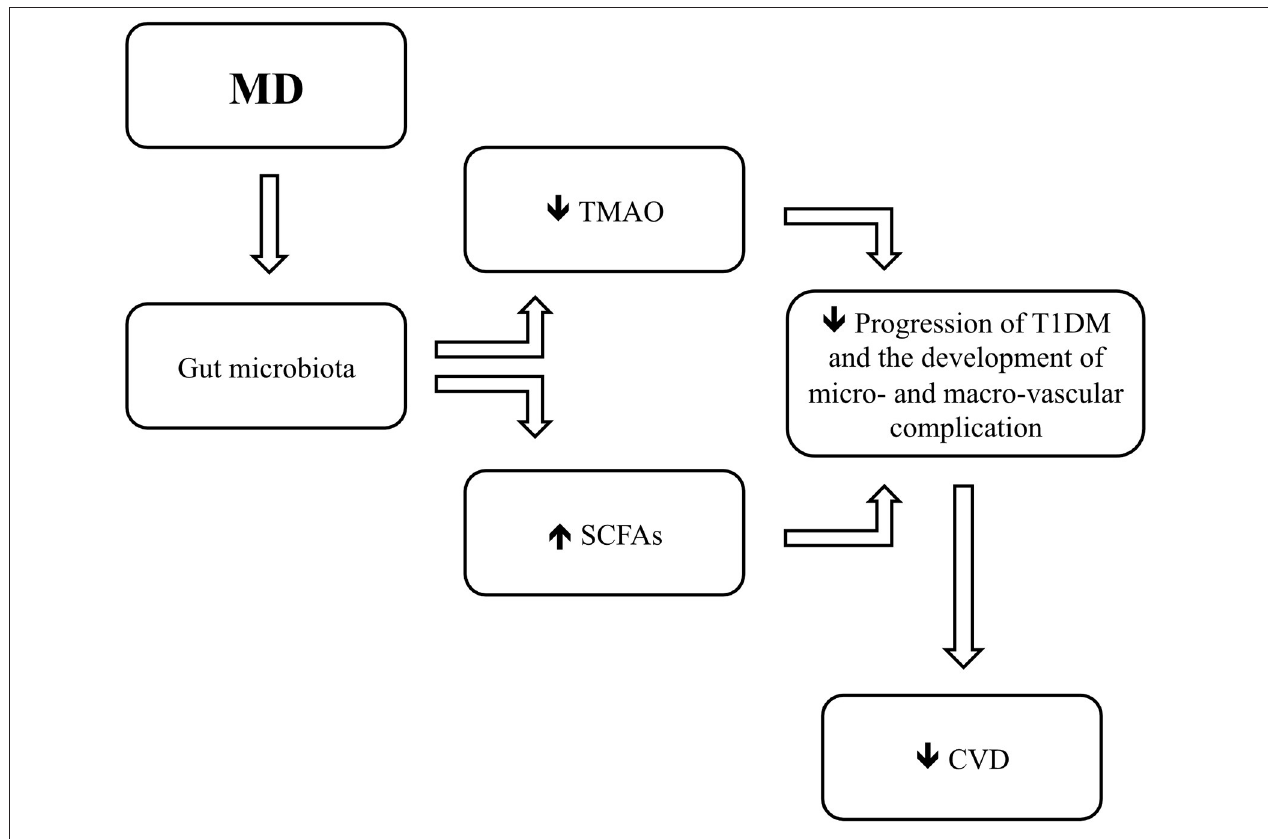
FIGURE 1 | Mediterranean diet (MD) induces changes in gut microbiota by promoting the growing of taxa which contribute to a greater formation of short-chai fatty acids (SCFAs) and to a lower production of trimethylamine N-oxide (TMAO), leading to a delay in the progression of type 1 diabetes mellitus (T1DM) and in the development of cardiovascular